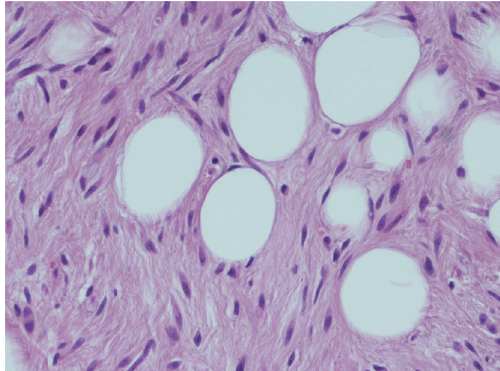
Figure 5: High-power view of strong uniform staining of spindle cells with antibody to CD34 (QBEND 10) (x100).